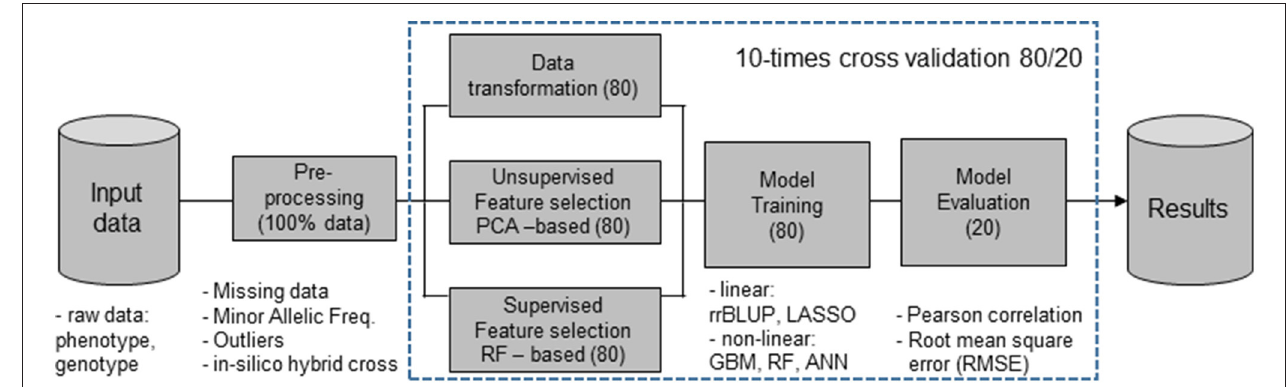
FIGURE 1 | Machine learning (ML) workflow that include feature selection (FS) methods [principal component analysis (PCA)], nonlinear dimensionality reduction [random forest (RF)], and random selection using 80% of the input data set, while the evaluation of prediction accuracies was done with the remaining 20%, the validation populations (VPs). Features obtained from the FS filter methods were combined with ridge regression best linear unbiased prediction (rrBLUP), least absolute shrinkage and selection operator (LASSO) regression, gradient boosting machines (GBM), artificial neural networks (ANN), and RF